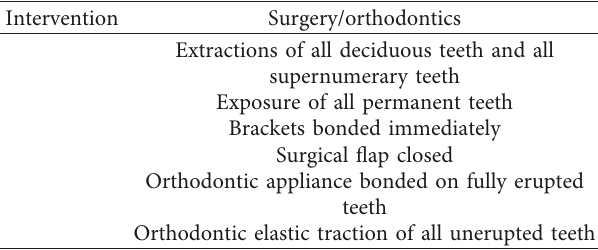
Table 3: Single surgery approach (Belfast-Hamburg). Intervention